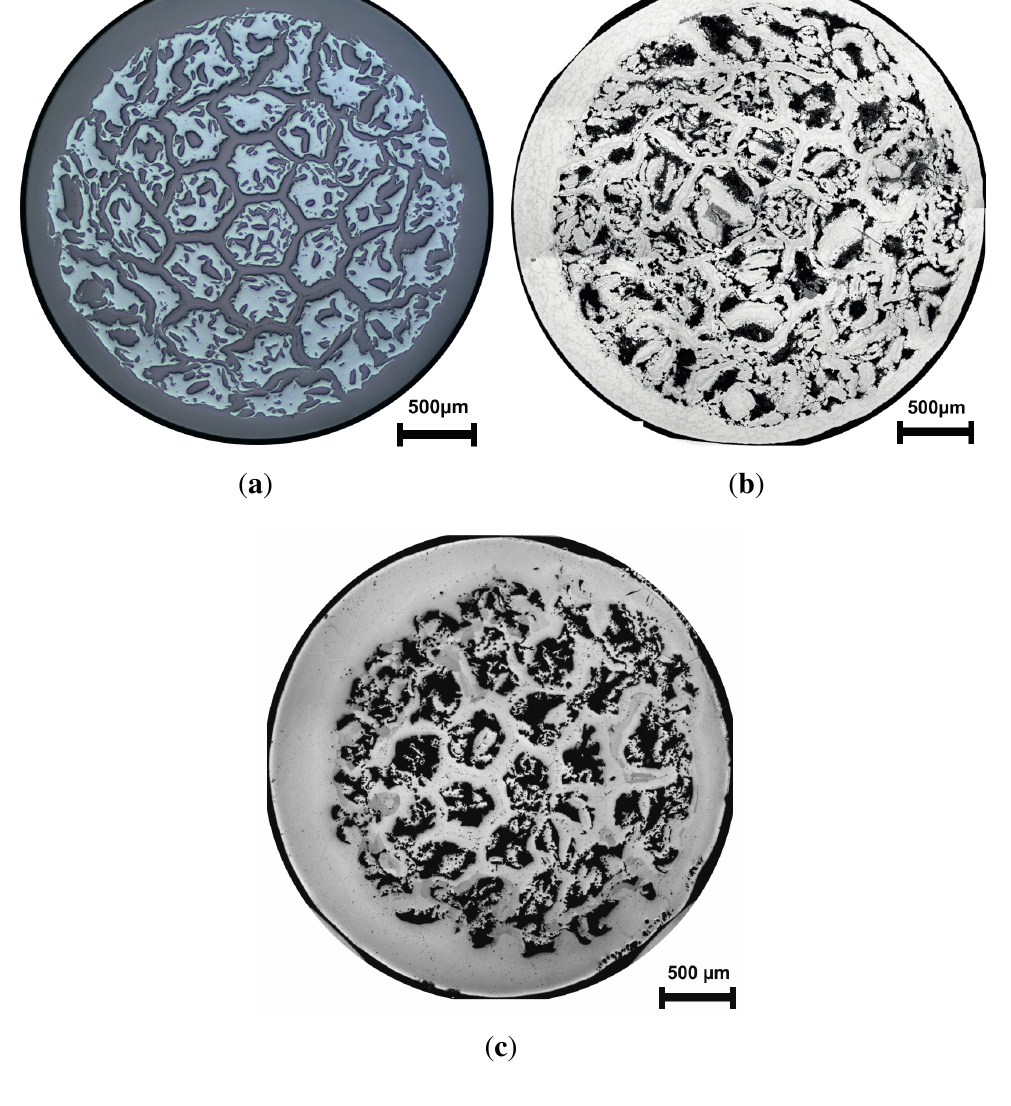
Figure 1. OM images of wire cross sections: ( a ) as prepared (dark: Ti, bright: Al); ( b ) after 12 h at 580 °C (black: pores, bright: Ti + TiAl treatment at 1300 °C (black: pores, bright: Ti